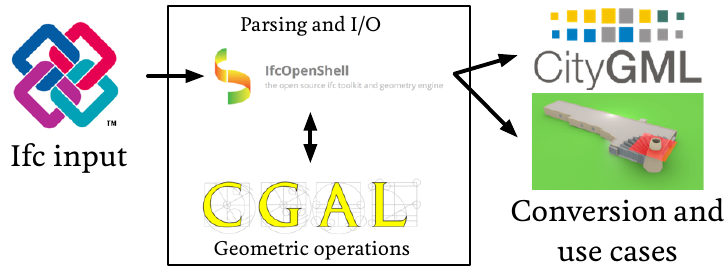
Figure 4. The initial